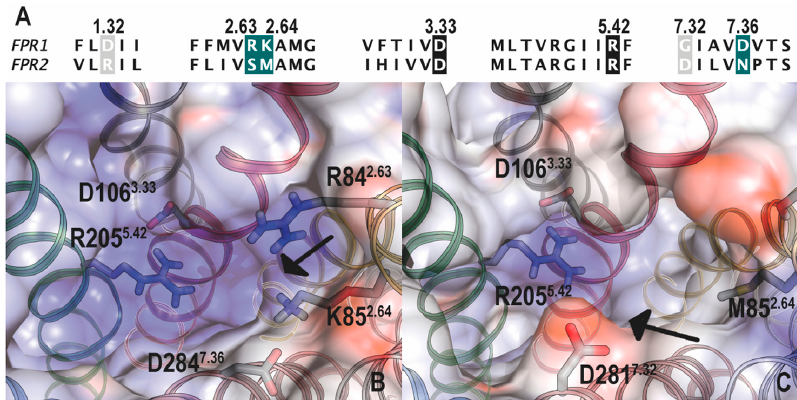
Figure 2. Comparison of FPR1 and FPR2 in selected regions. ( A ) Sequence alignment of FPR1 and FPR2. Residues referenced in the manuscript are boxed. Conserved side-chains between both receptors are shown in black, and major differences in amino acids are highlighted in green for N -formyl peptide binding to FPR1) or gray (for N -formyl peptide binding to FPR2). B and C, molecular electrostatic potential on the inner surface of the binding cavity of a computational model of FPR1 ( B ) and FPR2 ( C ), viewed from top of the receptors. FPR1 and FPR2 were modeled using the structure of the CXCR4 chemokine receptor as template. Arrows show key positive area in FPR1 due to Arg 84 and Lys 85 , and negative area in FPR2 due to Asp 281 sequence alignment and location of positive selection sites in FPR1, FPR2 and mFpr1 (see also Figure 1). Reproduced from [96] with permission. Using a similar approach of site-directed mutagenesis aided by computer modeling, another charged residue Asp 281 in FPR2 (Gly 280 in FPR1) was found to be crucial for the interaction of FPR2 with certain formyl peptides that contain a positively charged C-terminal residue (Figure 3), such as